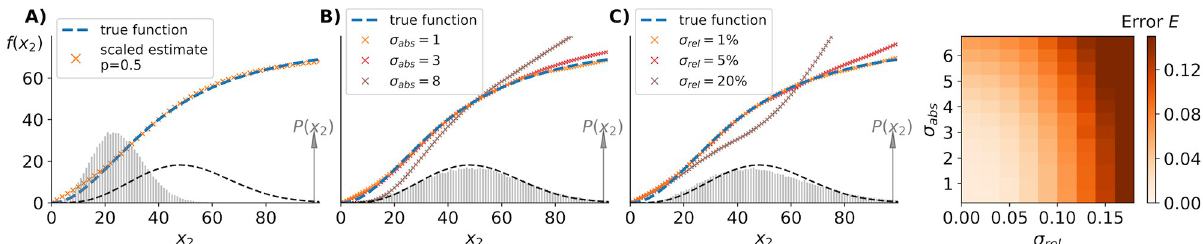
Fig 6. Small measurement noise does not prohibit accurate inference. A) Simulated “empirical” data (histogram) with binomial undercounting in which each molecule is detected with a fixed probability p . Our inference algorithm identifies the correct reaction rate if we simply multiply the measured molecule numbers by 1/ p again to obtain the input function (dashed blue line). If we do not know p then the algorithm identifies the correct shape f ( x 2 ) but cannot identify the correct scale of X 2 over which it varies. B) Simulated “empirical” data (grey histogram) with added absolute measurement errors modelled as a two-dimensional Gaussian with zero mean and standard deviation of σ theoretical one (dashed black line) and leads to significant deviations in the inference (brown crosses). For smaller absolute errors we observe satisfactory inference, as illustrated by the data for σ abs = 1, 3. C) Simulating relative measurement errors by multiplying “observed” samples from the exact stationary distribution with a random number from a two-dimensional Gaussian with mean one and standard deviation of σ relative errors less than 10% we found satisfactory inference but larger errors led to unacceptable estimates for the production rate f ( x 2 ) because of the significant deviation of the “empirical” distribution (grey histogram) from the exact stationary distribution (dashed black line) illustrated for σ Explicit de-convolution steps for known types of measurement noise may significantly improve the inference performance of future algorithms based on Eq (2). D) Quantifying the inference error for absolute and relative measurement errors. Relative measurement errors larger than 10% led to unsatisfactory